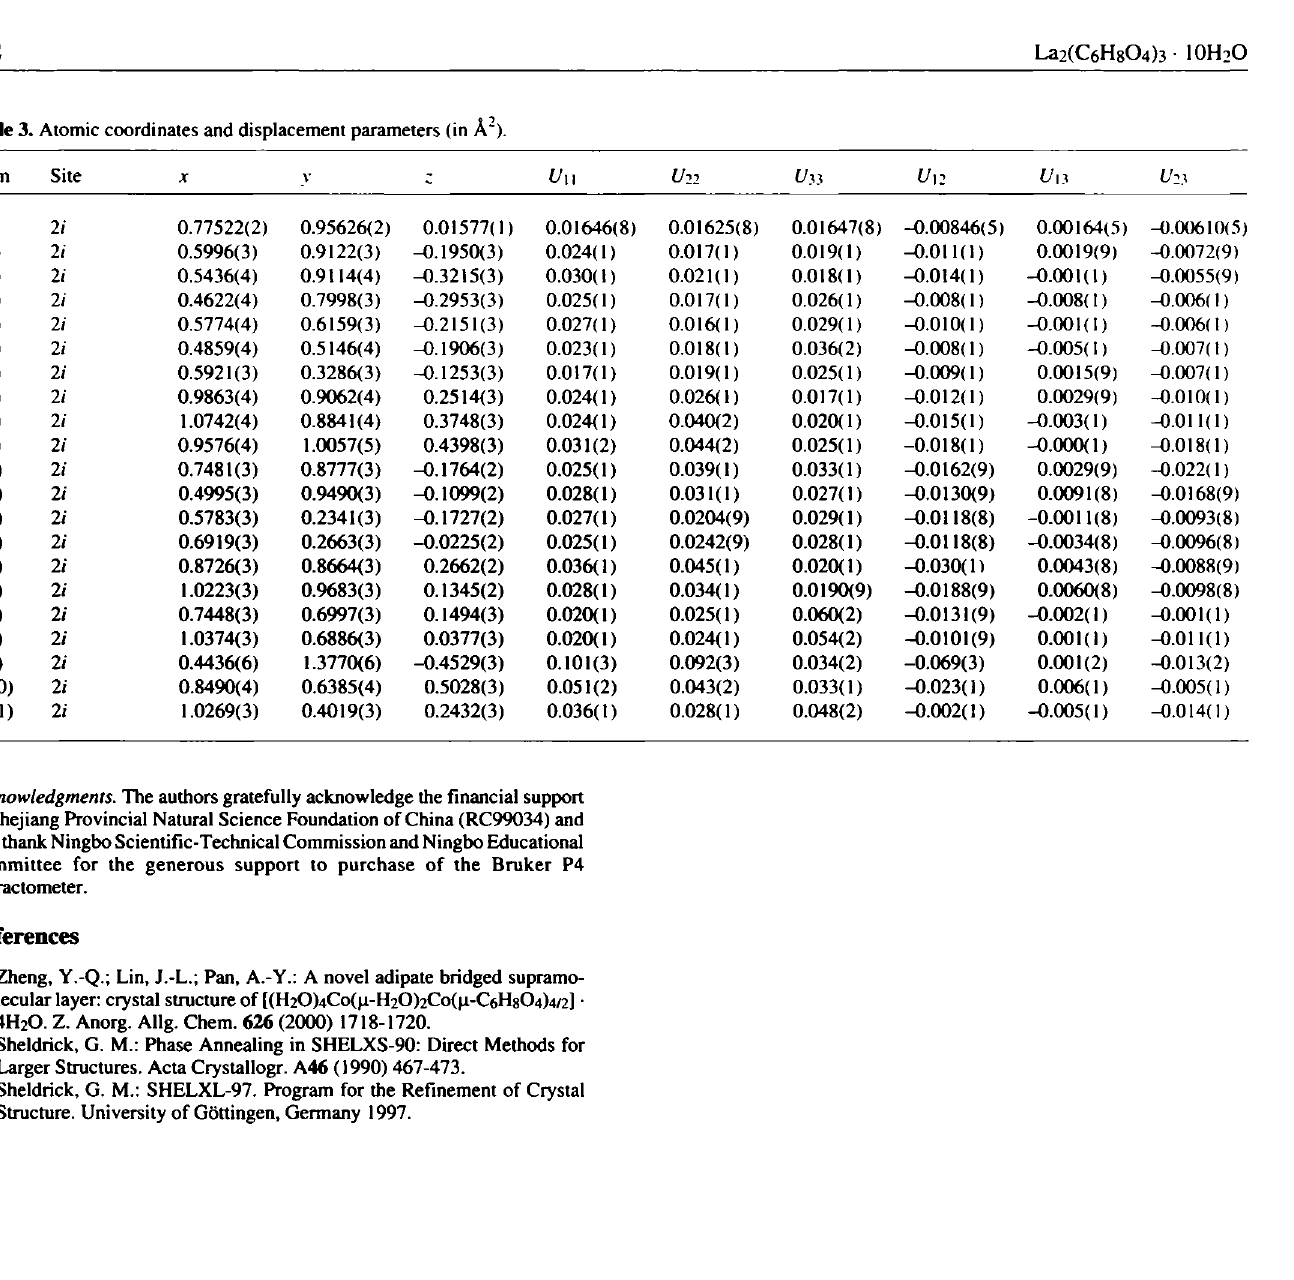
Table 3. Atomic coordinates and displacement parameters (in